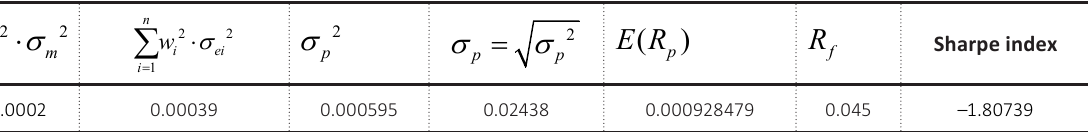
Table 7. Portfolio risk and portfolio